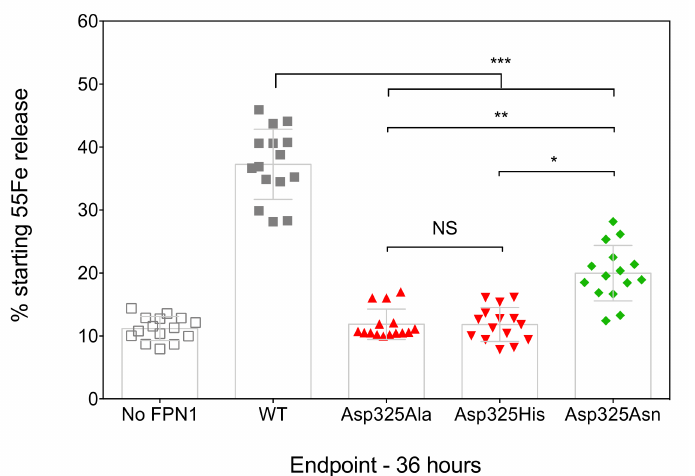
Figure 2. Effects of the Asp325Ala, His, and Asn variants on the iron export function of HsFPN1. HEK293T cells were transiently transfected with WT or mutated FPN1-V5 expression plasmids for 24 h before being grown in 20 µ g/mL 55 Fe-transferrin. After 16 h, cells were washed and then serum-starved for up to 36 h. Data are presented as percentage cellular radioactivity at time zero. The error bars represent the standard deviation of 5 independent experiments (performed in triplicate; n = 15). p values were calculated using Student’s t -test. * p < 0.05, ** p < 0.01, and *** p <